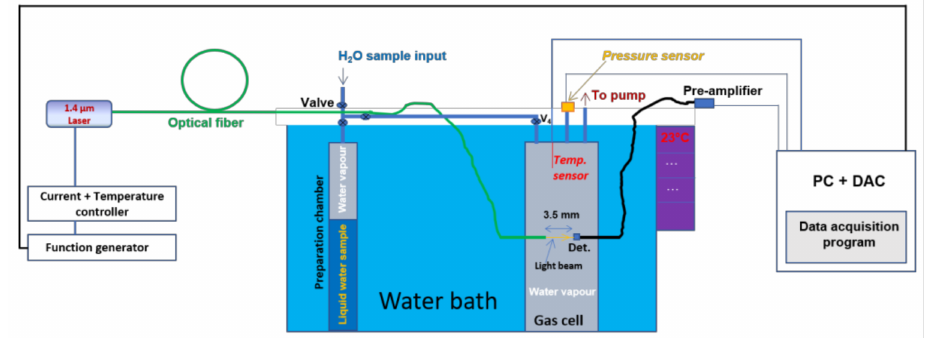
Figure 1. Schematic of the setup used for self-broadening measurements and temperature depen- dence. Det: